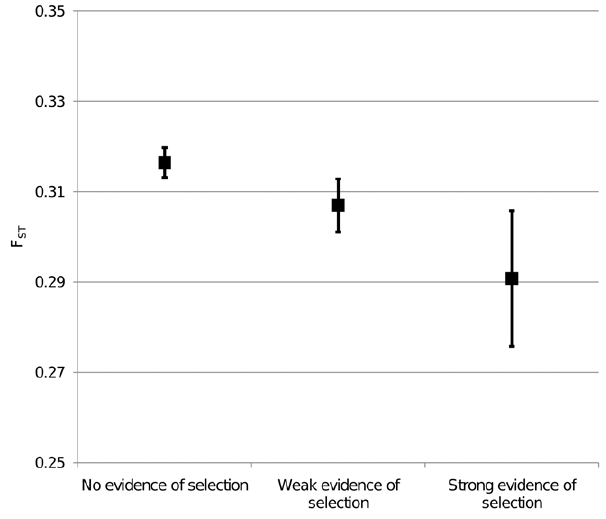
Figure 3. Mean F ST value of genes with and without interspe- cific evidence of positive selection. Genes were grouped according to the strength of evidence of their positive selection across six species [23]. Vertical bars represent 95% confidence interval.